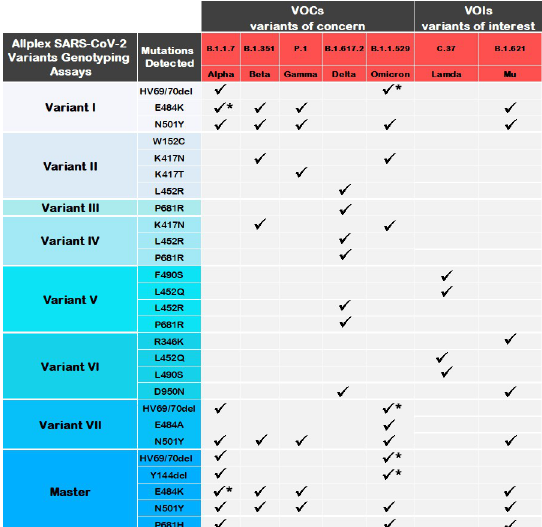
Fig 2. Current Allplex Seegene variant genotyping assays. Mutations detected by each assay and the corresponding variants are shown. Asterisks indicate variants for which the indicated mutation is not present in all sub-lineages.